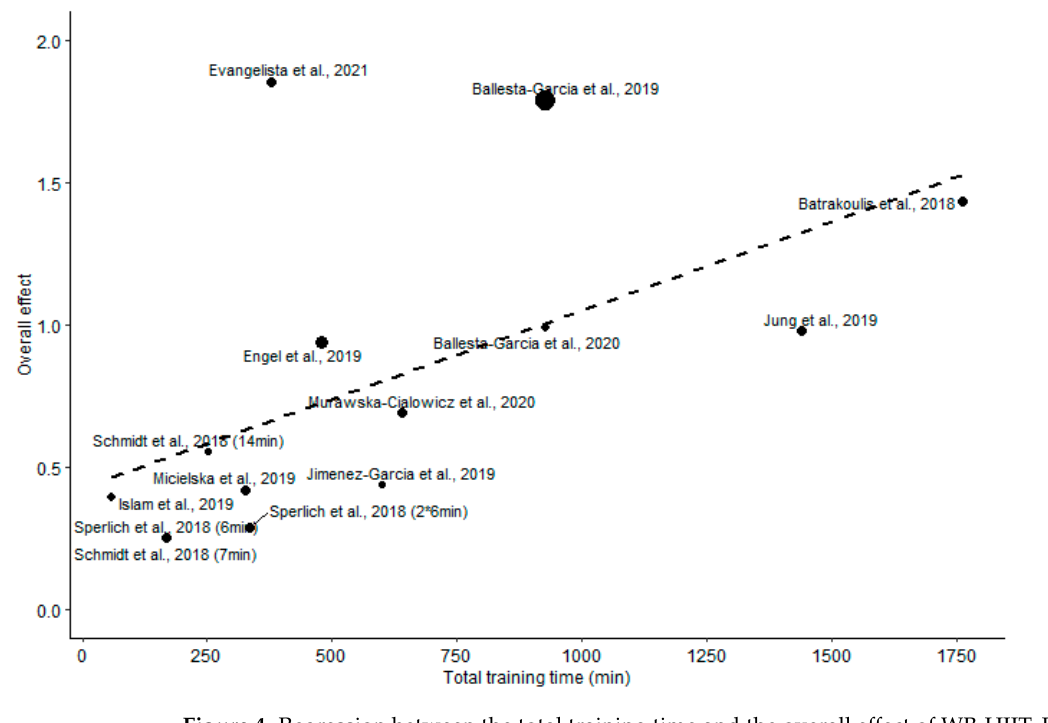
Figure 4. Regression between the total training time and the overall effect of WB-HIIT. Filled circles size is proportional to the study weight. Table 4. Association between total training time of WB-HIIT and overall effect or effect on individual components (per hour of training).